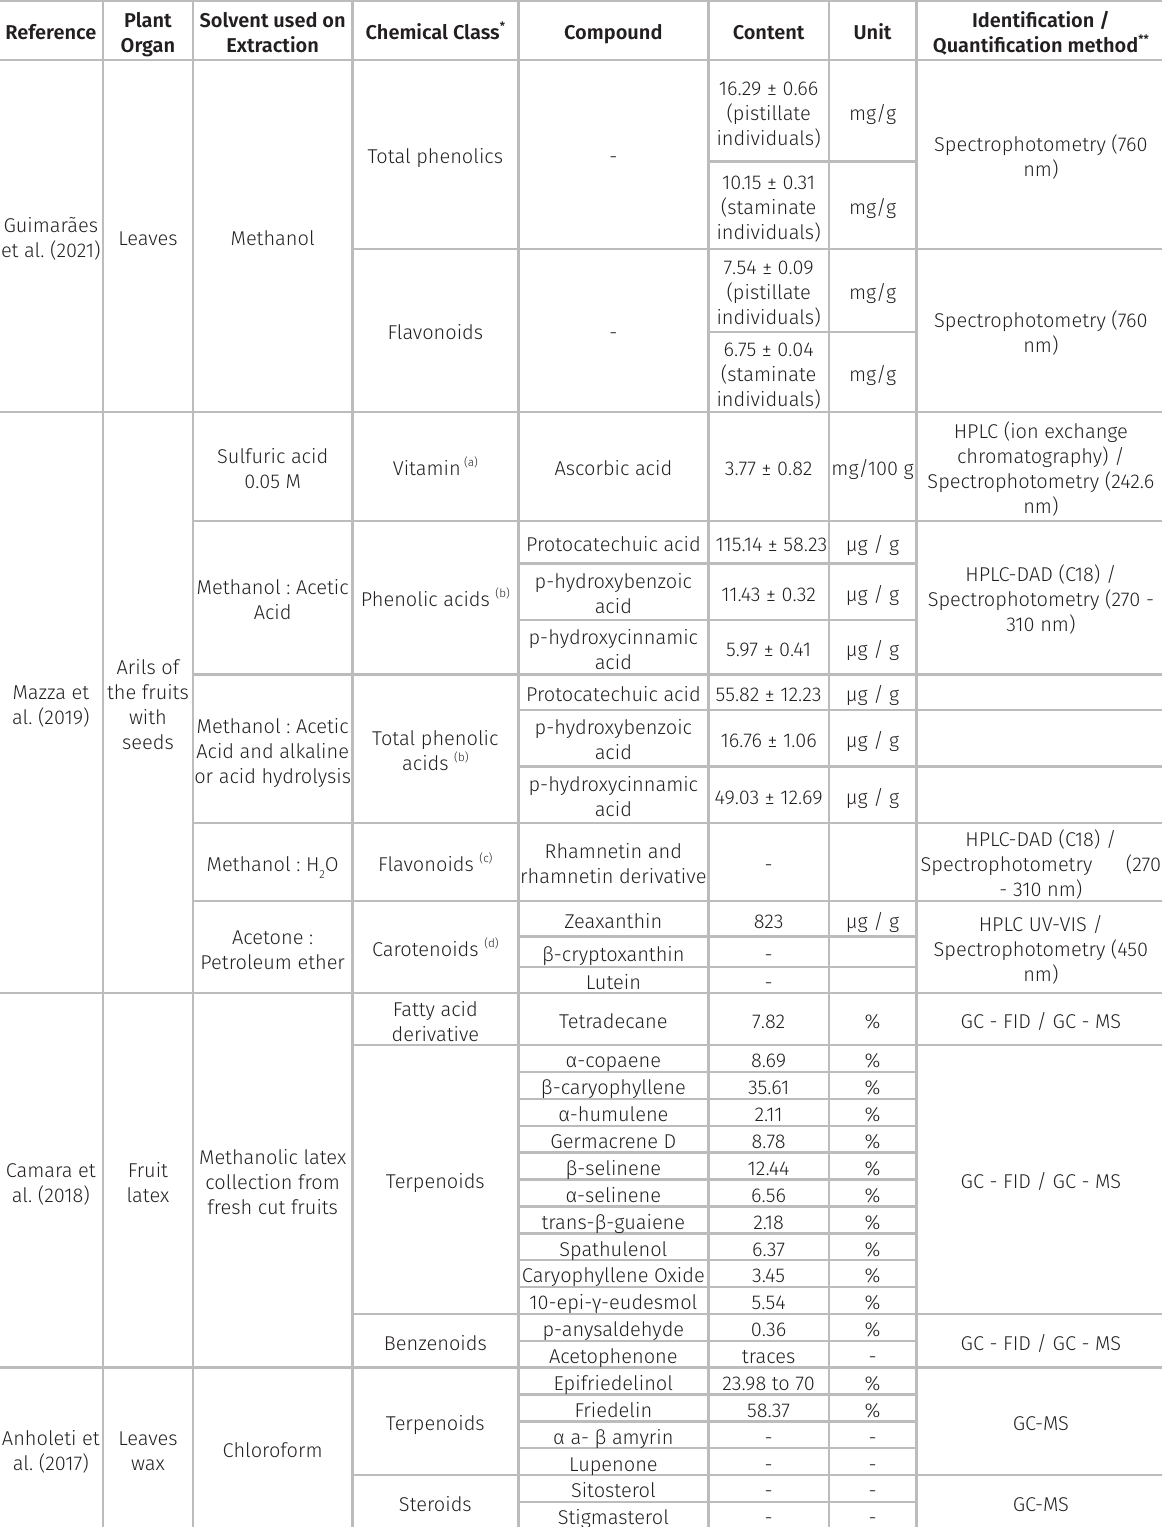
Table I. Clusia fluminensis phytochemical profile.